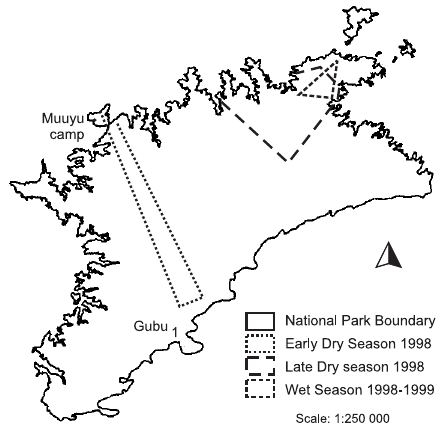
Fig. 3. Map of MNP indicating seasonal ranges of a hand raised rhino,’Cuckoo’. 1 = Release site.